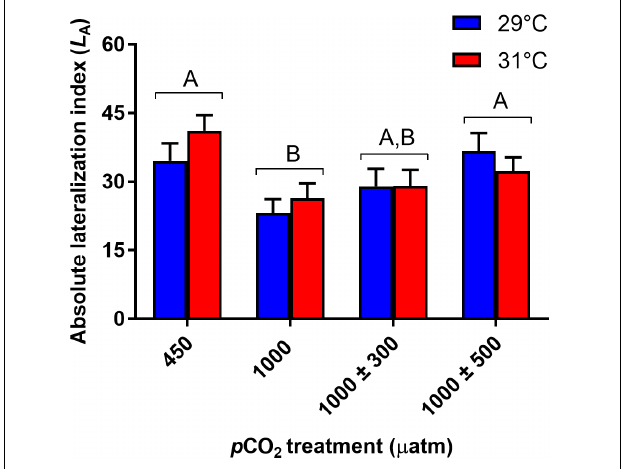
FIGURE 2 | Effects of elevated CO 2 on absolute lateralization ( L A ) in juvenile A. polyacanthus. Different letters represent significant differences between p CO 2 treatments (Tukey, P < 0.05). Bars represent means ±